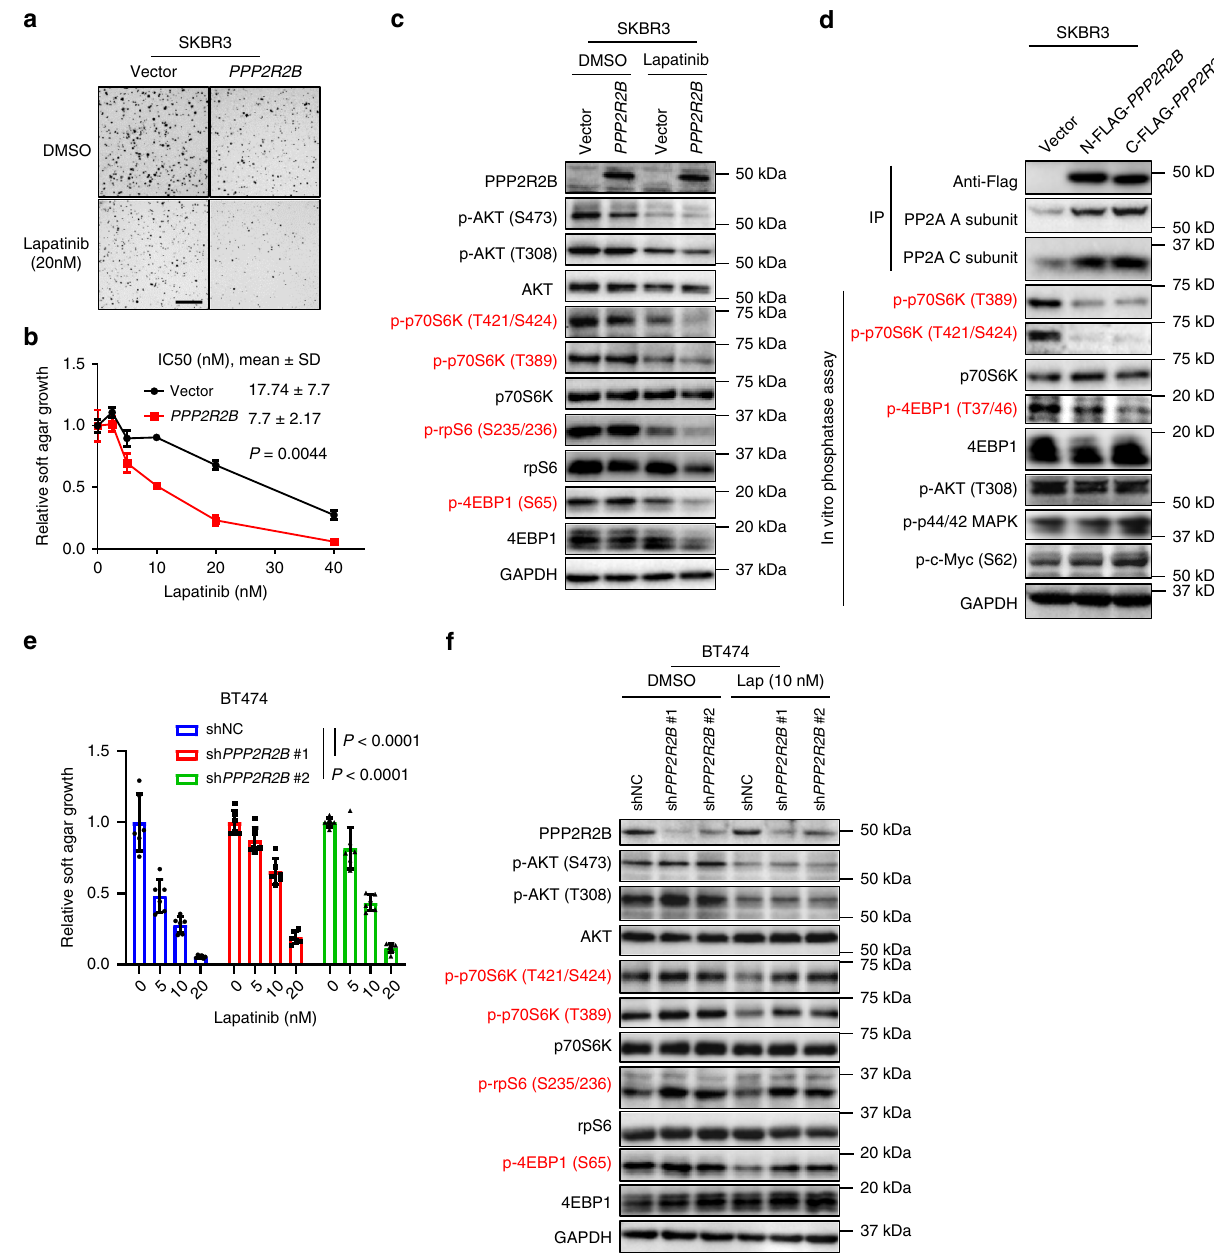
Fig. 3 Functional validation of PPP2R2B in modulating response to HER2-targeted therapies. a Representative images ( n = 9) of soft agar assay with SKBR3 cells transduced with either the empty vector (Vector) or the vector containing PPP2R2B , and treated with the indicated concentration of lapatinib. Scale bar: 1.5 mm. b Quanti fi cation of soft agar assay performed with cells from a and treated with the indicated concentrations of lapatinib. Data are expressed as means ± s.d. of technical triplicates and representative of three independent overexpression experiments. The indicated IC50s were calculated with the three independent experiments and the P value was determined by comparing the IC50s from Vector to the ones from PPP2R2B , with two-tailed Student ’ s t -test. c Representative western blot analysis ( n = 2) with cells from a treated with lapatinib at 40 nM. d PPP2R2B-PP2A in vitro phosphatase assay ( n = 1) using anti-FLAG immunoprecipitates (IP) from SKBR3 expressing empty vector (Vector), N-FLAG- PPP2R2B , or the C-FLAG- PPP2R2B , incubated with whole cell lysate from SKBR3. e Soft agar assay with BT474 transduced with shNC or shRNAs against PPP2R2B and treated with the indicated concentrations of lapatinib. Data are expressed as mean ± s.d. of two independent experiments performed in triplicate ( n = 6). P values were determined by two-way ANOVA. f Representative western blot analysis ( n = 2) with cells from d treated with lapatinib (Lap) at 10 nM. Effectors downstream of mTOR were highlighted in red in a , d , and e